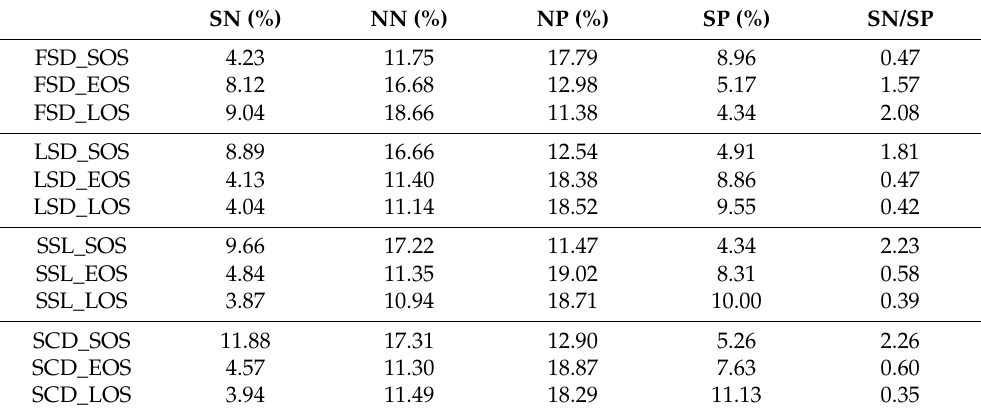
Figure 8. Correlation between different land surface phenology metrics and different snow seasonality metrics. “Significant” means p < 0.1. Table 1. Area of significant correlation between snow season metrics and phenology metrics (%), SN for significant negative ( p < 0.1) correlation and NN for nonsignificant negative ( p > 0.1, r < − 0.2) correlation. SP for significant positive ( p < 0.1) correlation and NP for nonsignificant positive ( p > 0.1, r > 0.2) correlation.